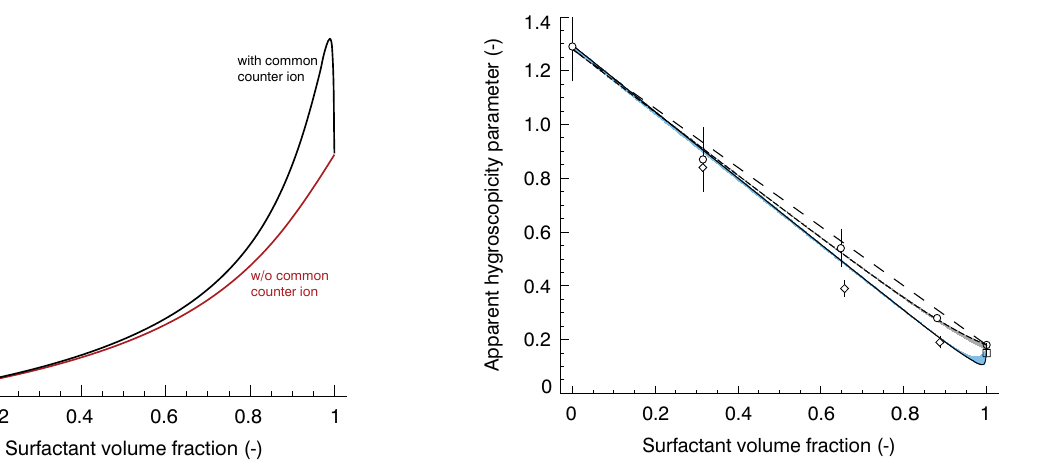
Fig. 1. Dependence of the critical supersaturation on SDS volume fraction for the NaCl/SDS system using partitioning theory without common counter ion for D d = 40nm (Eq. 5, red line) and partition- ing theory accounting for the common counter ion for D d = 40nm (Eq. 8, black line).